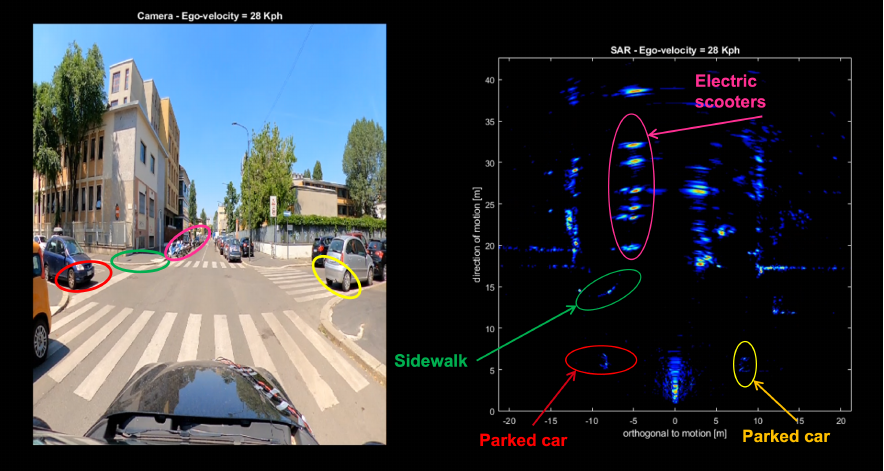
Figure 11. SAR imaging in an open road (forward-looking configuration): ( left ) camera image; ( right ) SAR image. Several details are visible such as the parked cars to the left (red circle) and to the right (yellow circle), the sidewalk (green circle) and the parked electric scooters (purple